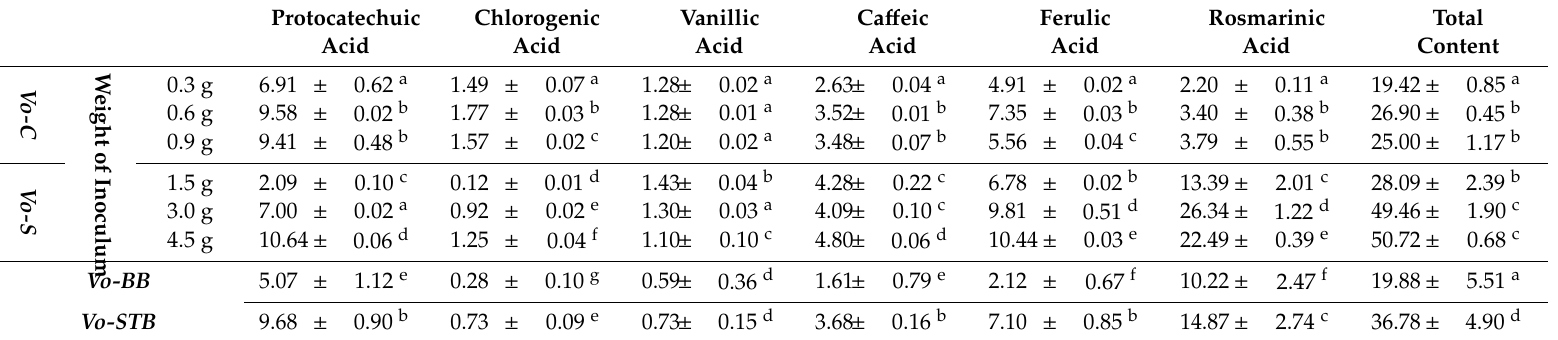
Table 2. Phenolic acids accumulation (mg / 100 g DW ± SD) in studied callus, suspension and bioreactor V. o ffi cinalis in vitro